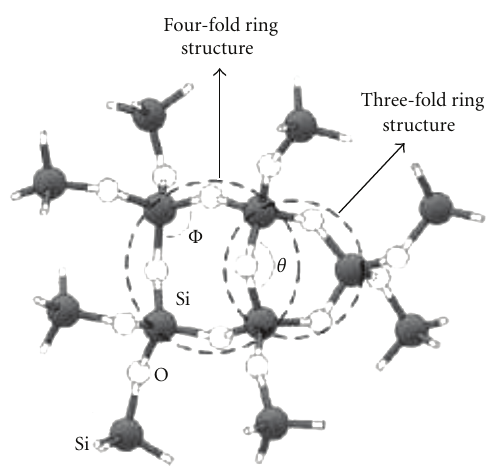
Figure 2: Ball and stick model of fused silica in random network (encircled are three-fold and four-fold ring structures) (reproduced from [10]).